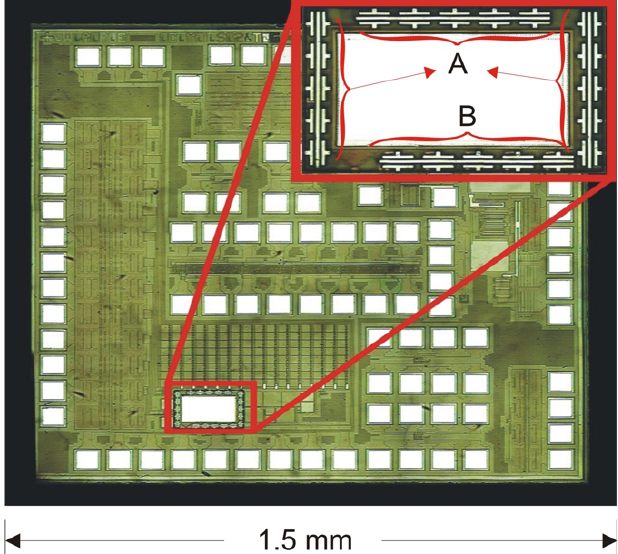
Figure 6. Optical microscopy of the full chip. Inset shows the opening in the passivation layer with exposed electrodes. “A” indicates the electrodes connected to the amplifier. “B” indicates the free electrodes connected directly to the external pads.